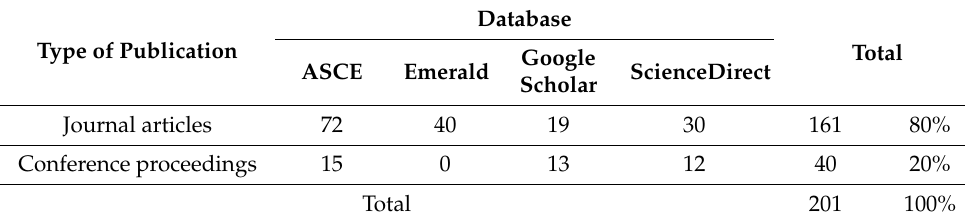
Table 2. Publication type of the analyzed studies.